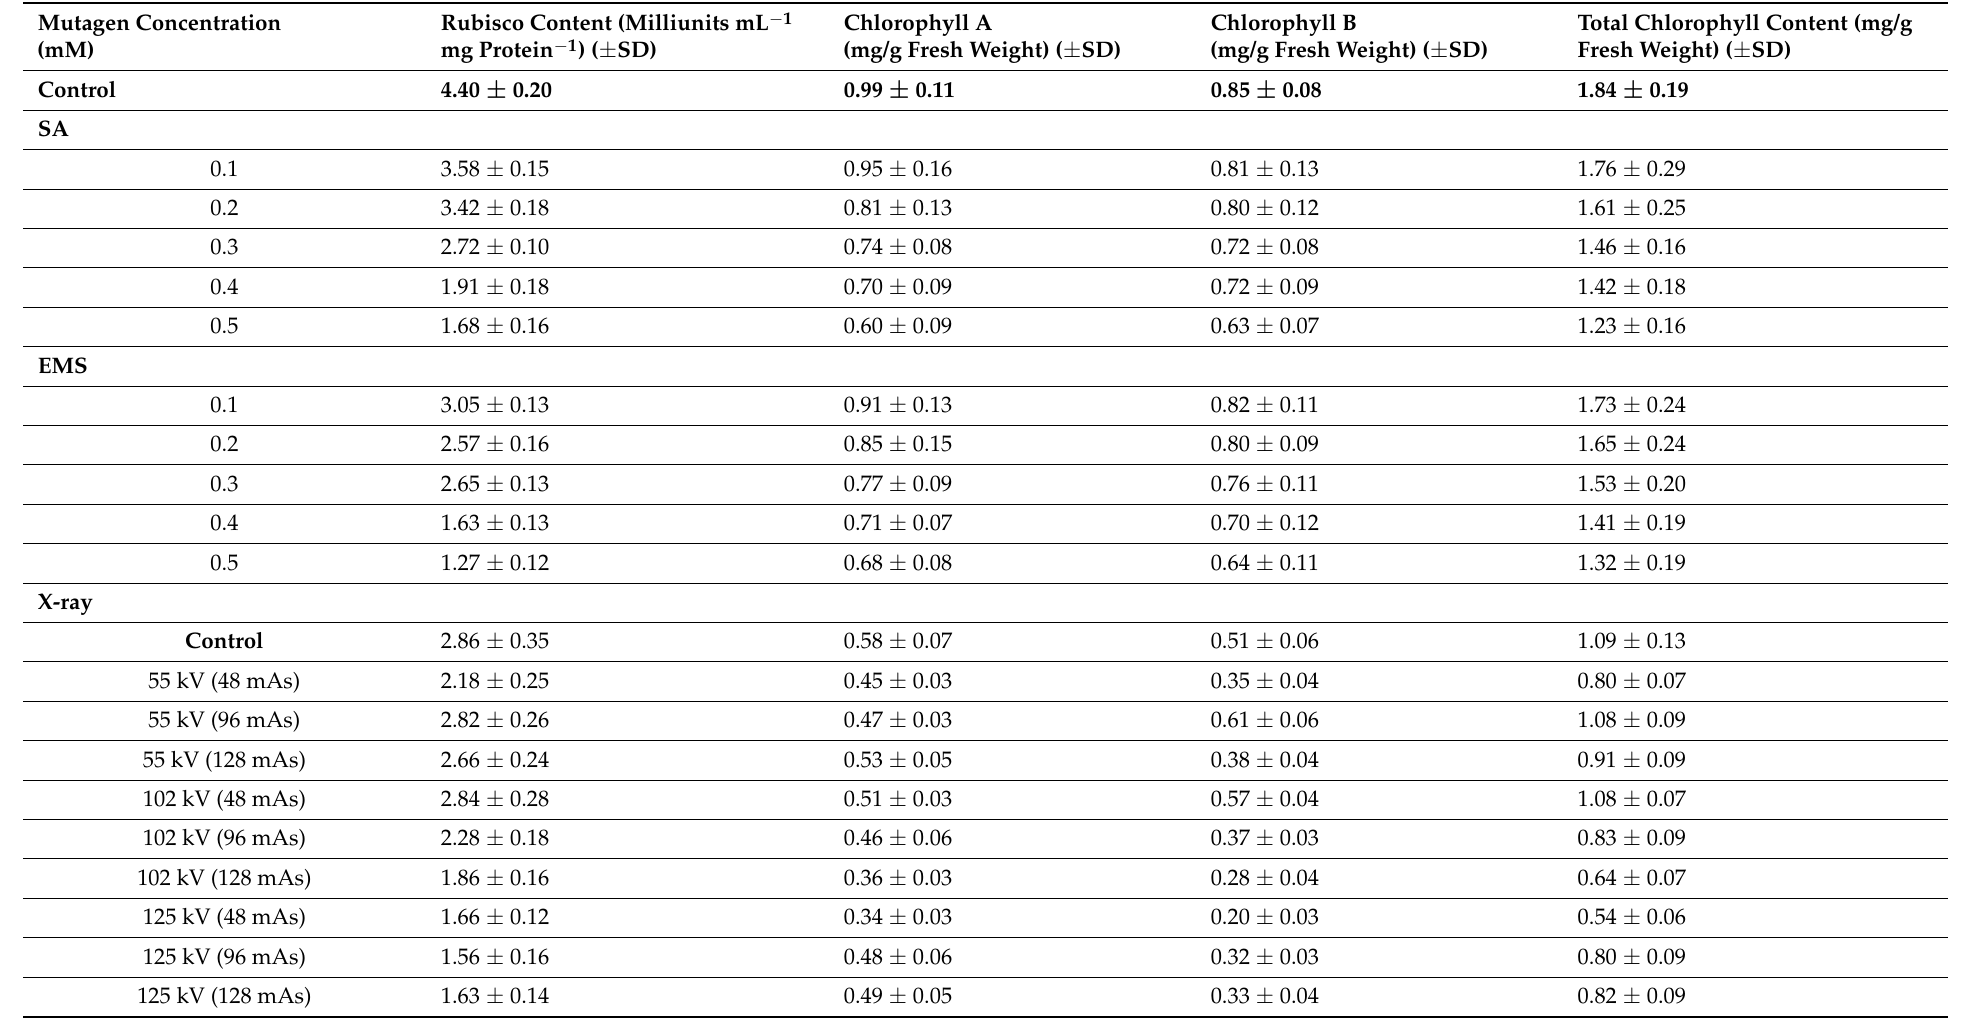
Table 1. Chlorophyll content and Rubisco activity of SA-, EMS-, and X-ray-mutated M 0